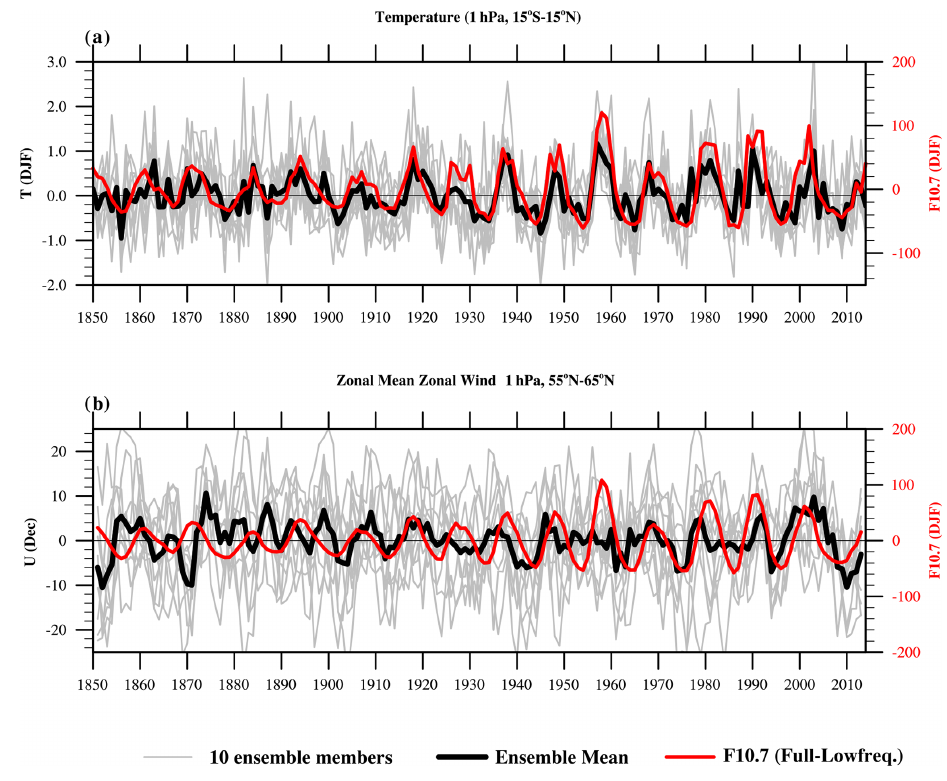
Figure 3. Direct solar cycle signal in the upper stratosphere. (a) Time series of the tropical stratopause temperature (1hPa, 15 ◦ S–15 ◦ N) averaged over the winter season (DJF) for the individual ensemble members (thin gray lines), ensemble mean (thick black line), and the solar cycle index F10.7 (red line). (b) Same as (a) but for December zonal mean zonal wind averaged over 55–65 ◦ N, 1hPa, smoothed with a 3-year running mean. To isolate 11-year solar cycle effects, differences between the FULL and the LOWFREQ ensemble simulations have been calculated. The gray lines include internal variability and the 11-year solar signal, their spread represents the internal variability, and the ensemble mean (thick black line) represents the 11-year solar cycle signal. The 11-year solar cycle has been isolated in a similar way from the original solar forcing time series by subtracting the low-frequency part of the solar forcing (Fig.